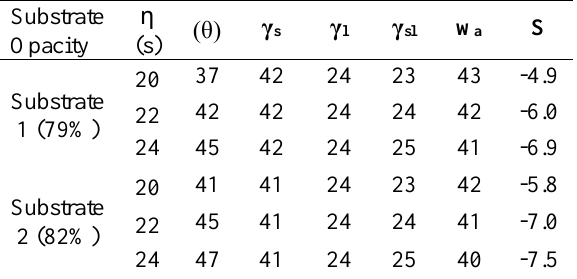
Table 3. Substrate-ink